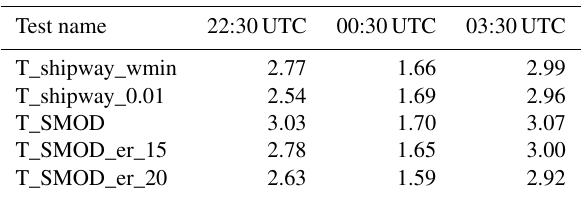
Table 6. Ratio of modelled to observed cloud drop number aver- aged over the vertical height across tested time frames (3 significant figures